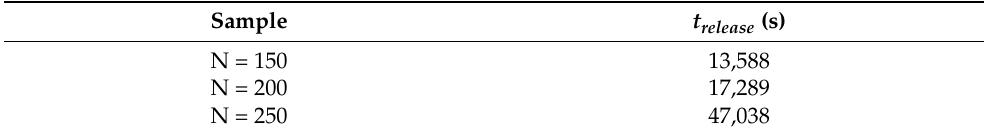
Table 2. Characteristic Release Times estimated from the time evolution of the ratio between the signal band intensity and the reference band